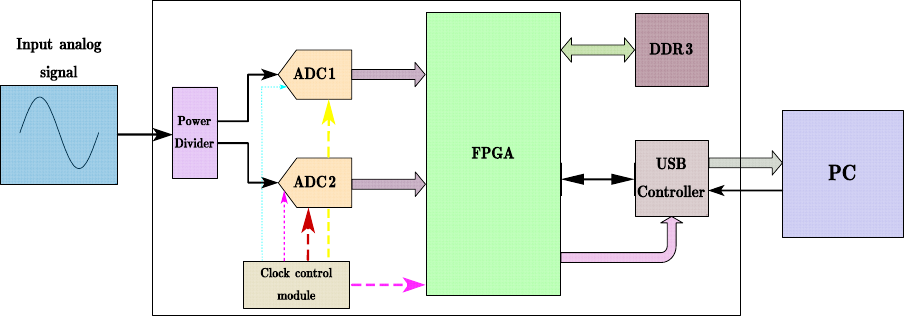
Figure 7. General structure block diagram of a 16-bit, four-channel TIADC data acquisition sys-